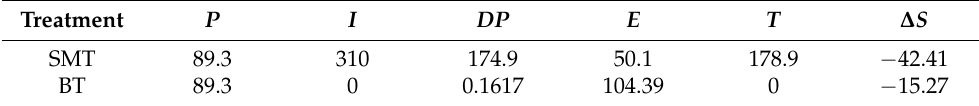
Table 6. Field water balance (mm) for SMT and BT during simulation periods.